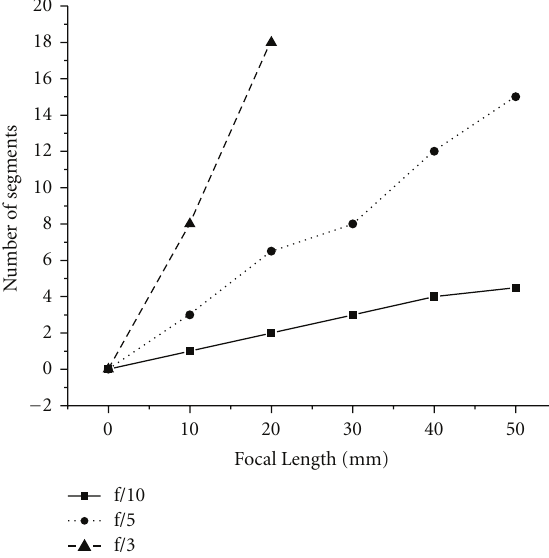
Figure 3: Hybrid achromat ( M = 1) number of di ff ractive segments versus focal